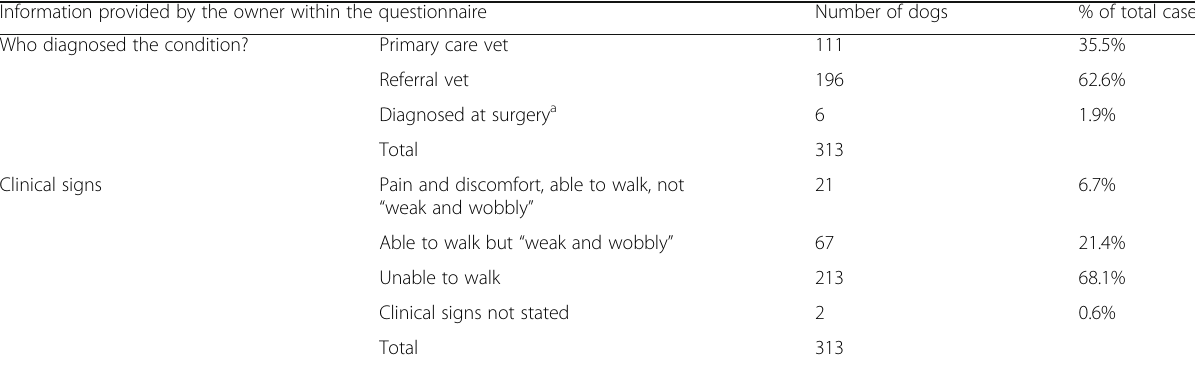
Table 6 Information about the 313 cases of IVDH Information provided by the owner within the questionnaire Who diagnosed the condition?